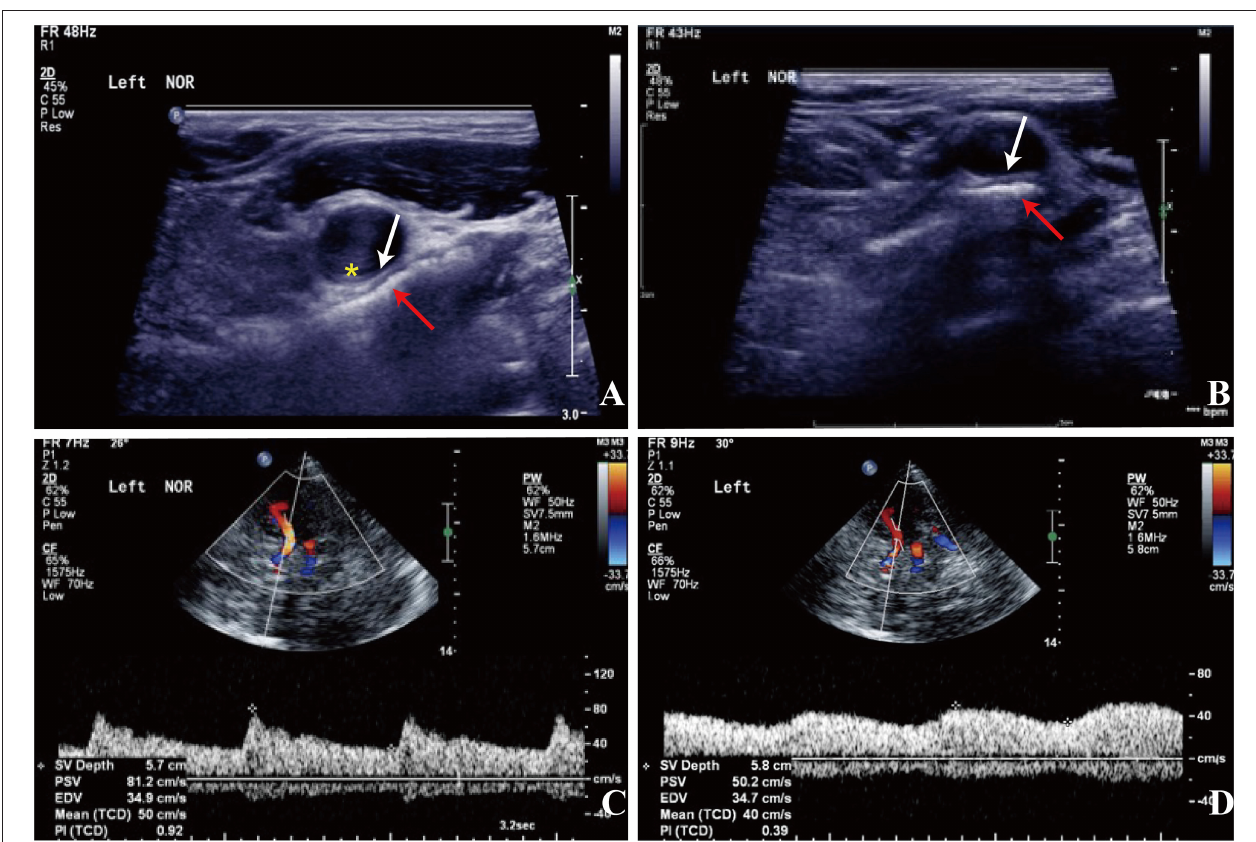
FIGURE 2 | Carotid doppler ultrasound spectrum (DUS) (A,B) and TCCD (C,D) . (A,B) There was a heterogeneous echo outside the left carotid bifurcation, and the lumen at the distal end of the left CCA was compressed by the hyoid bone in the rotated neck position (red arrow: the hyoid bone; white arrow: compressed arterial lumen; yellow asterisk: increased IMT). (C) The flow velocity of the left MCA was normal in the neutral position. (D) The flow velocity of the left MCA decreased significantly with neck